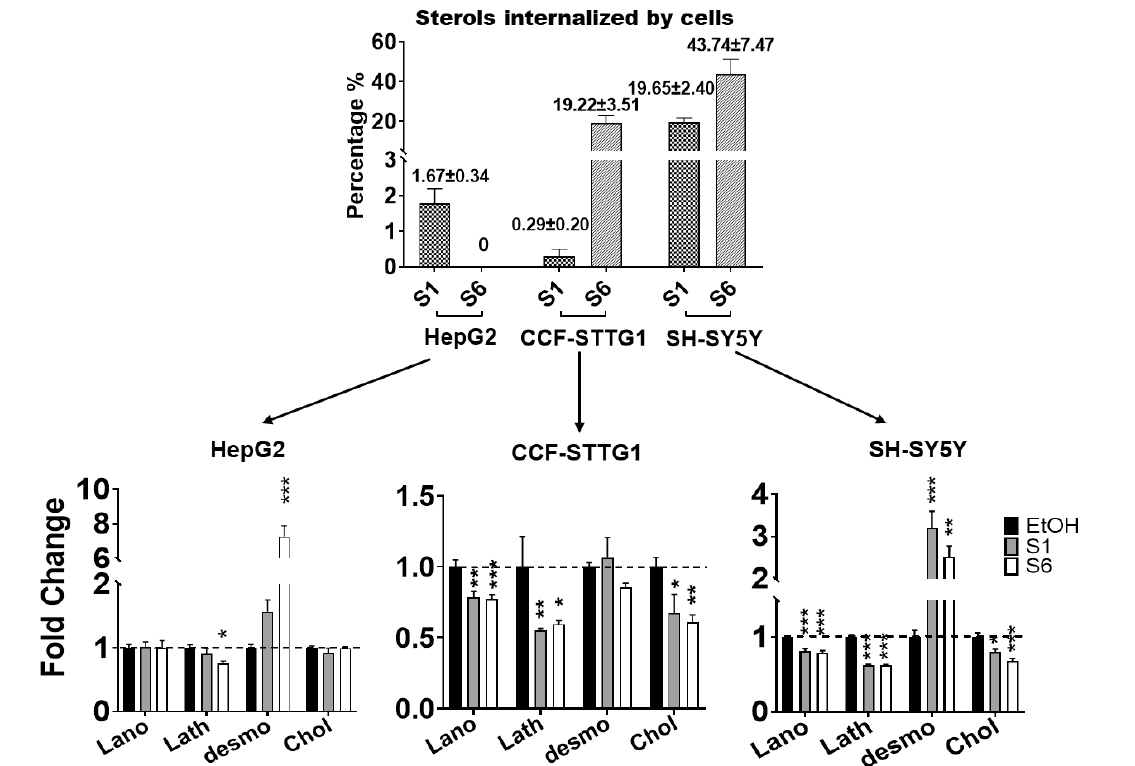
Figure 6. S1 and S6 regulate cholesterol biosynthesis in a cell type-specific manner. Lanosterol (Lano), lathosterol (Lath), desmosterol (Desmo), and cholesterol (Chol) were quantified in S1 or S6 loaded cells (HepG2, CCF-STTG1 and SHSH-5Y) using GC-MS method. Fold change compared to the vehicle control. Each bar represents the mean ± SD of three separate experiments, each performed in triplicate ( n = 9). Significance is compared to the control (EtOH) value: * p ≤ 0.05, ** p ≤ 0.01, *** p ≤ 0.001.